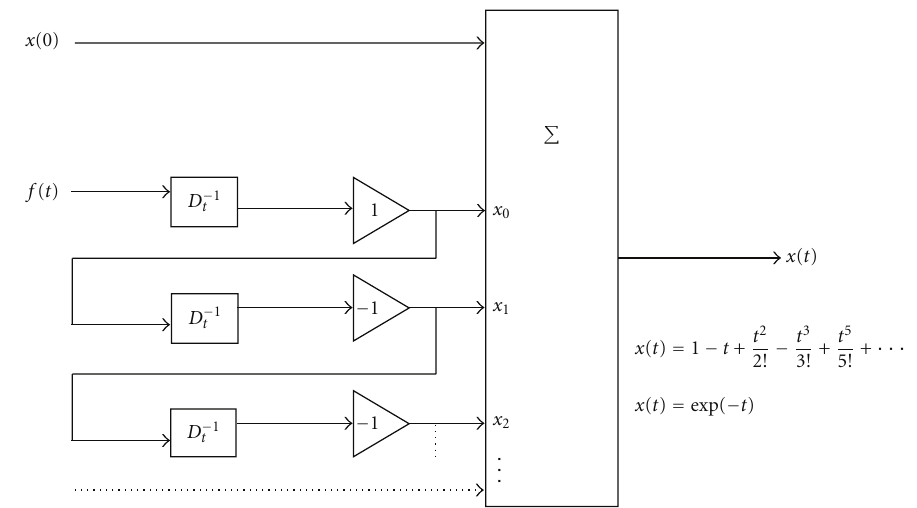
Figure 2: Block showing solution of first order di ff erential equation by